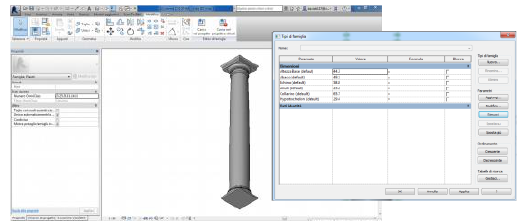
Figure 10. HBIM model of the “hall of columns”